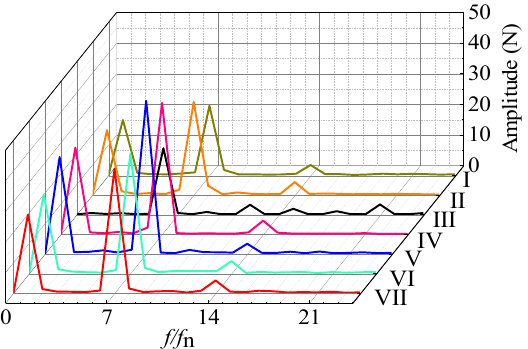
Figure 18. Frequency ‐ domain diagram of the radial force under 1.0 Q des conditions.